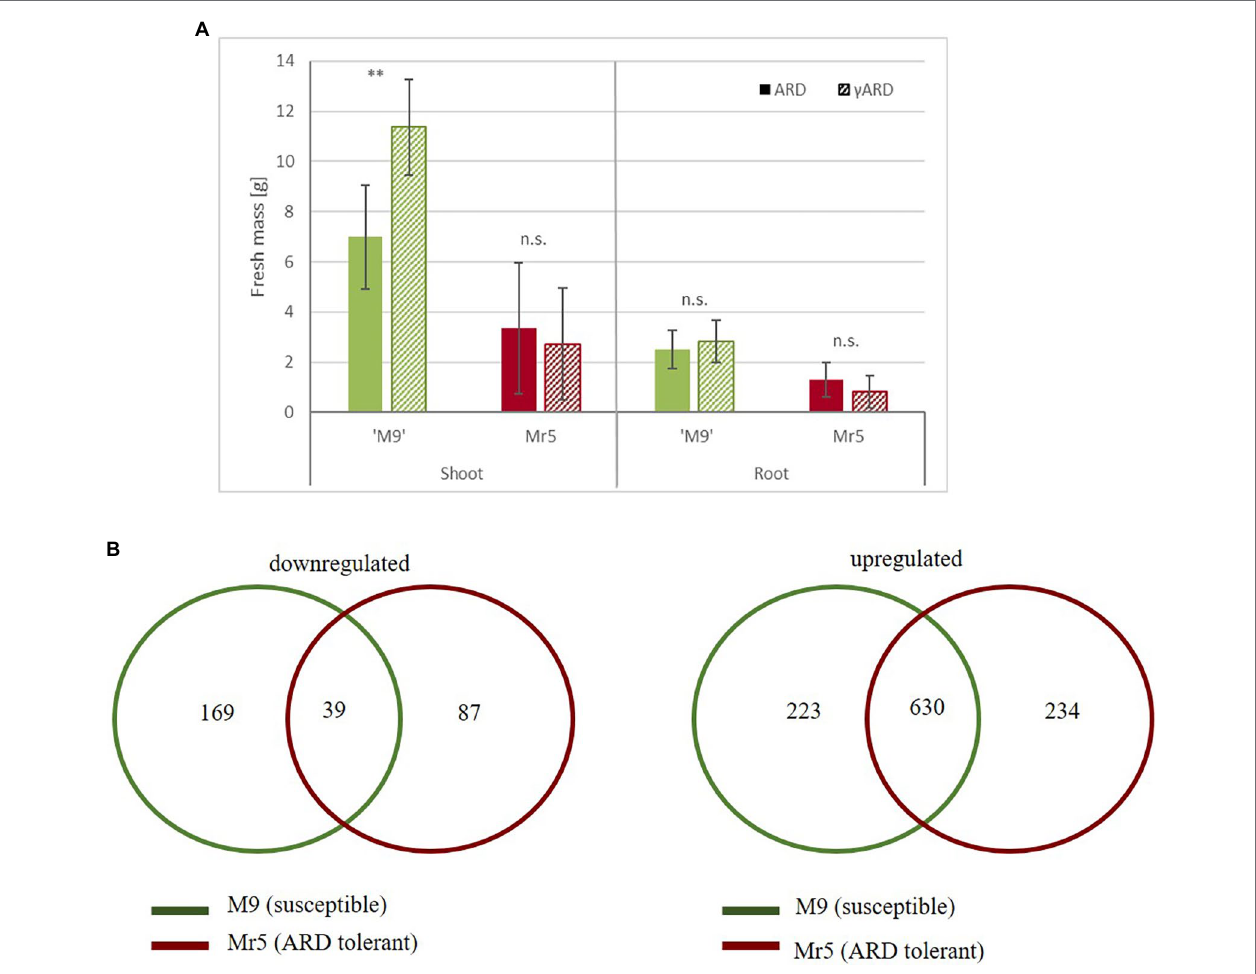
FIGURE 1 | Biomass and gene expression comparisons between the susceptible rootstock ‘M9’ and the ARD tolerant wild apple genotype Mr5 in response to ARD. (A) Fresh mass ( g ) of ‘M9’ (green) and Mr5 (red) after cultivation in ARD soil and γ ARD soil ( n = 5; given are means and SD). Comparisons between ARD and γ ARD variants were analyzed by ANOVA (n.s. = not significant; ** = p < 0.01). (B) The Venn diagrams indicate the number of common and exclusive DEGs (threshold = 1), separately for the downregulated and upregulated genes. DEGs exclusively detected in ‘M9’ are indicated in the green circle, DEGs exclusively detected in Mr5 are indicated in the red circle. Some DEGs were counted twice, because they were upregulated in one genotype and downregulated in the other. Thus, the overall sum of DEGs of both Venn diagrams is higher than the total DEG